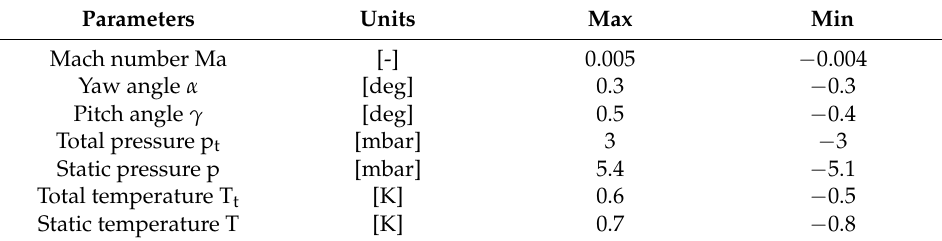
Table 2. Measurement Uncertainties of the Five-hole Probe